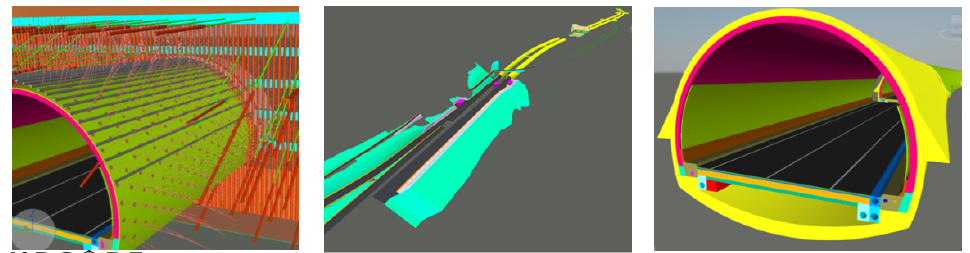
Figure 5. BIM methodology focused on the complete life cycle of the infrastructure: model view with geotechnical information ( left ); general model view ( centre ); model view for checking interference in facilities ( right ).